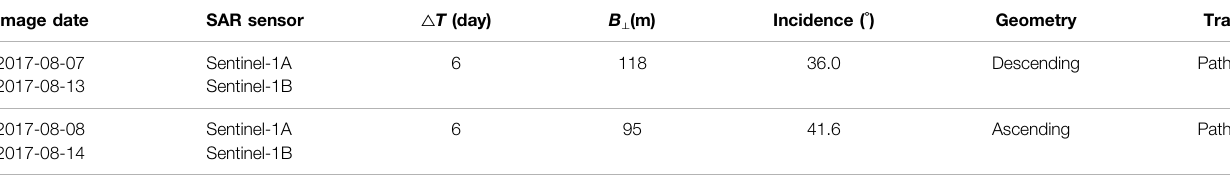
TABLE 1 | InSAR data for the Jinghe